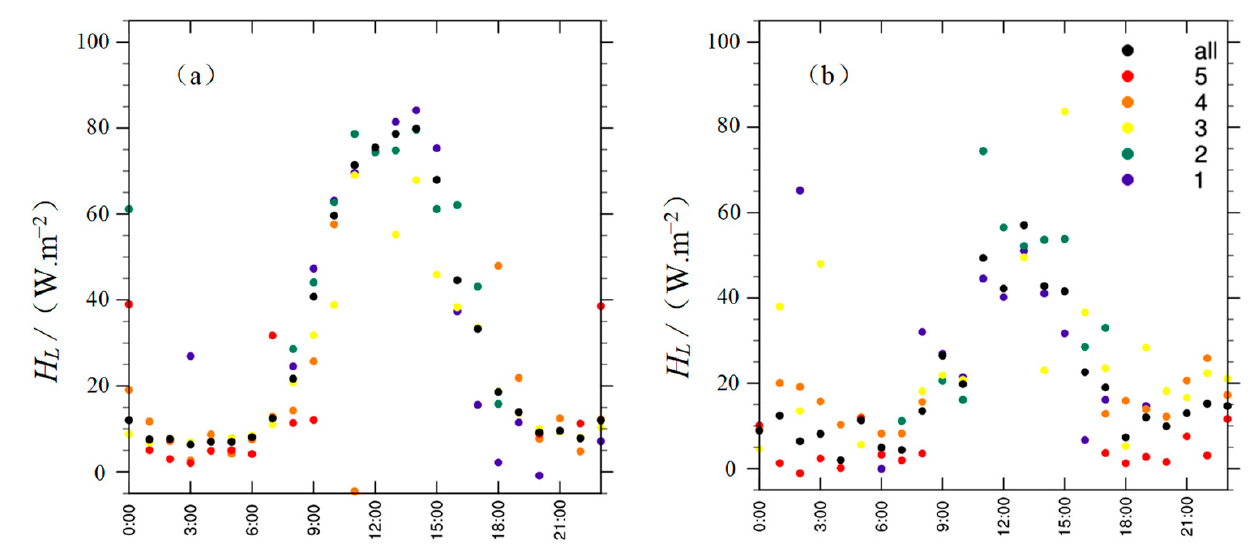
Figure 8. The diurnal variation of the latent heat flux in different atmospheric stabilities at ( a ) site 1 and ( b ) site 2. Stability level 1: unstable; 2: weak-unstable; 3: neutral; 4: weak-stable; and 5: stable.